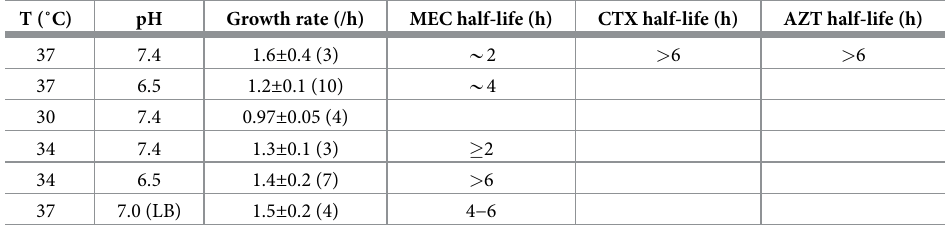
Table 1. Bacterial growth rates and antibiotic half-lives in MOPSgluRDM at varying temperature and pH growth rates were measured by applying a linear fit to the log of the optical density (the number of replicates used is indi- cated in the brackets). The antibiotic half-lives measured with the delay-time bioassay are also listed, for mecillinam (Mec.), cefotaxime (Ctx.) and aztreonam